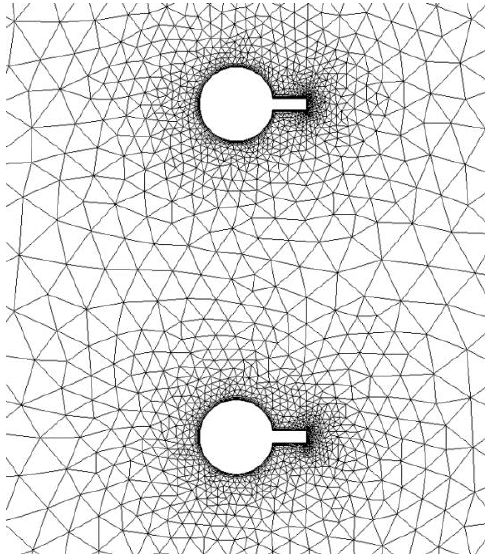
Energies 2021 , 14 , x FOR PEER REVIEW Figure 6. Computational meshes around the ammonia injection nozzles and the turning-diffusing parts.